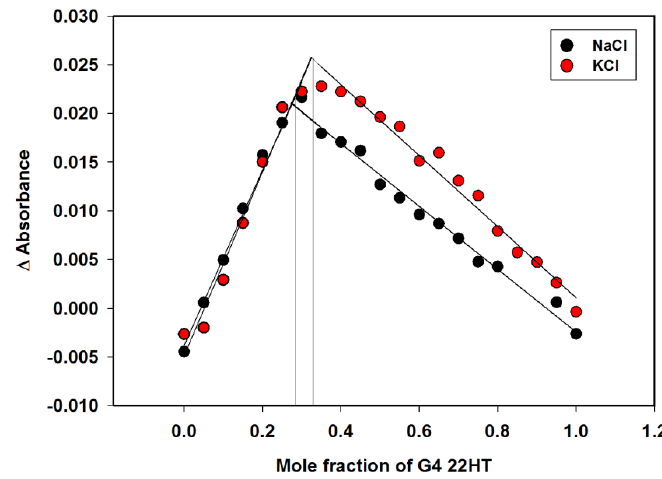
Figure 6. Job plots for the binding of compound 3 to 22HT G-quadruplex in Tris-HCl buffer containing 100 mM NaCl or KCl.